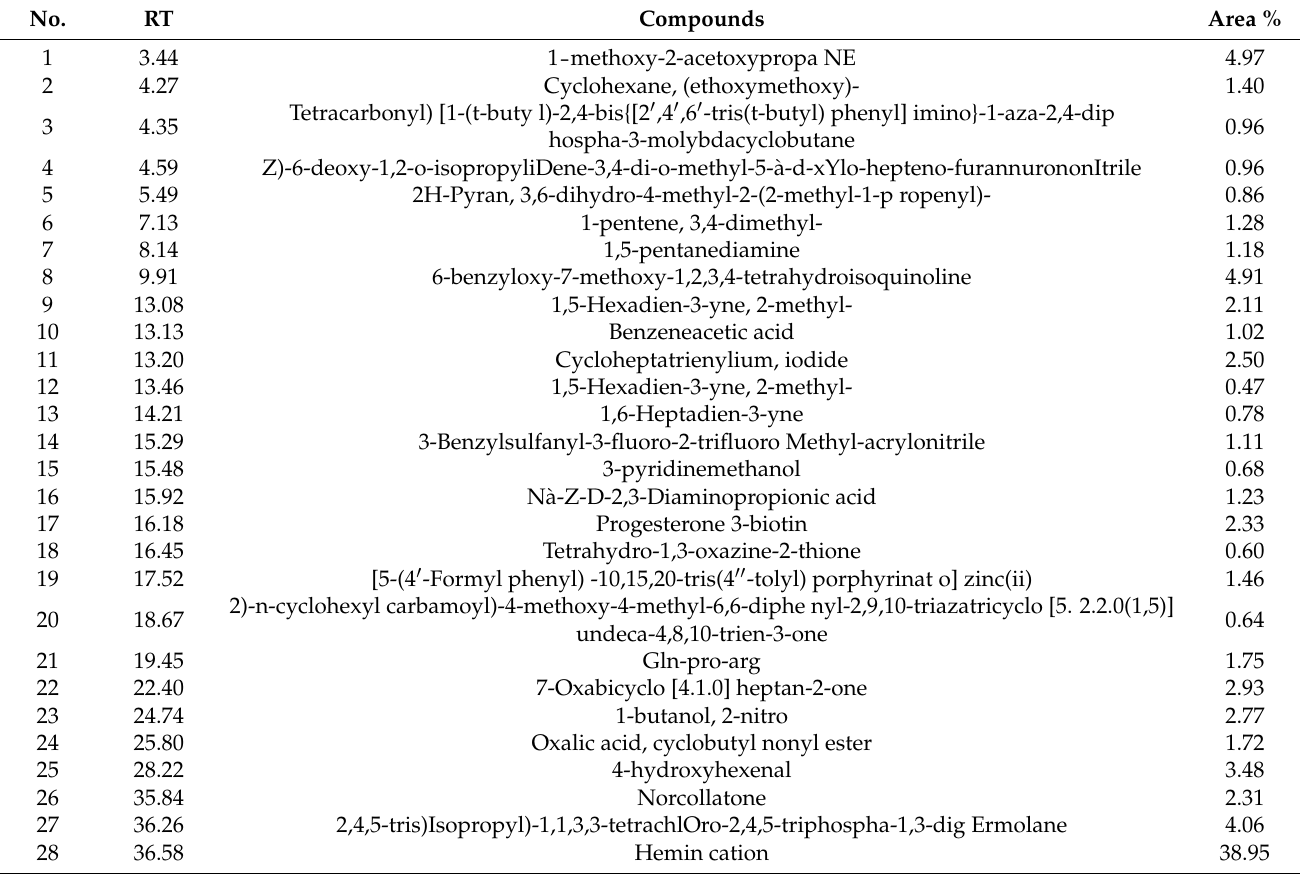
Table 6. Composition of the T. asperellum (MW965676) culture filtrate.